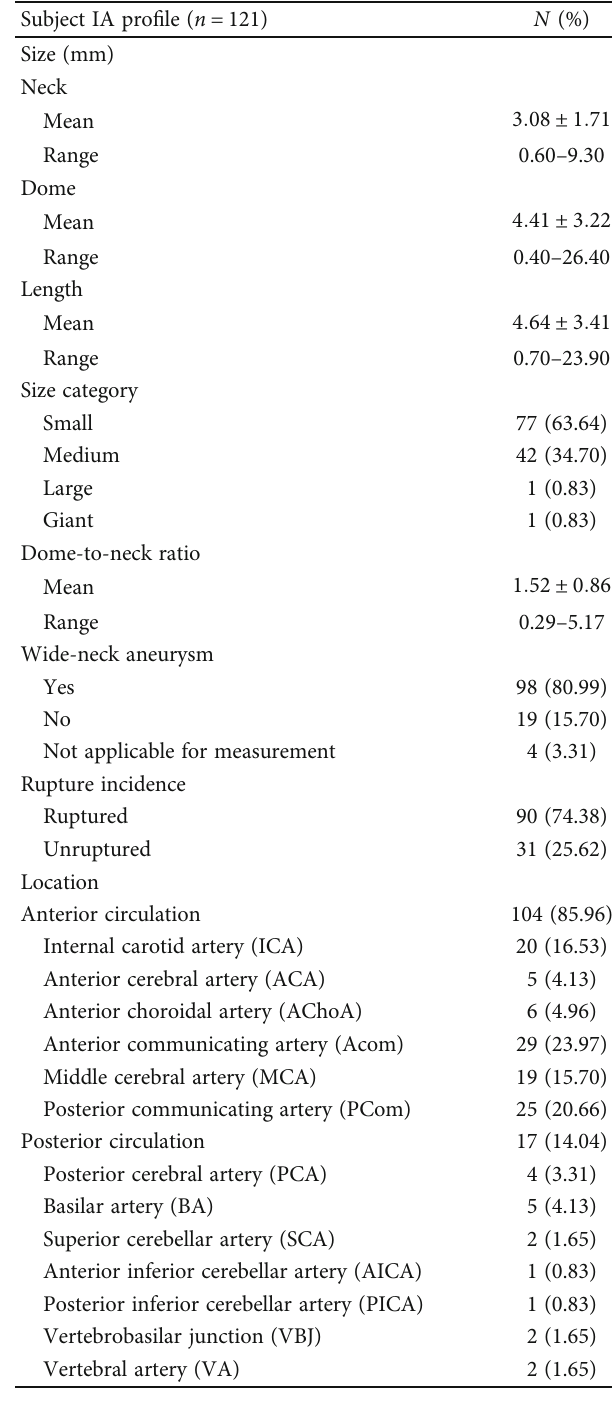
Table 1: Demographic data of subjects. Table 2: Intracranial aneurysm pro fi